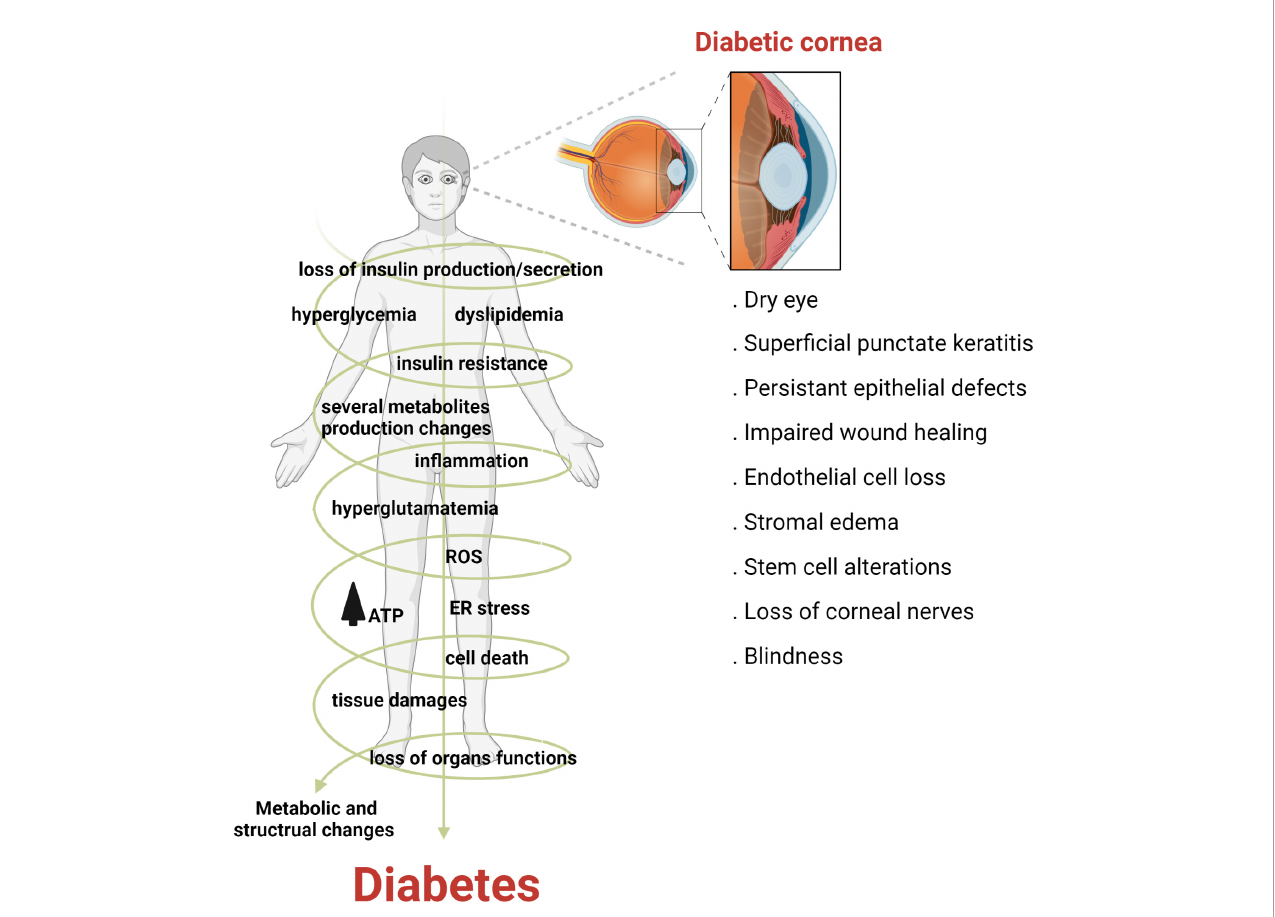
FIGURE2 Diabetes adversely effects the cornea. Diabetes is a multifactorial disease characterized by metabolic dysfunction throughout the human body. In the cornea, diabetes can cause a host of complications ranging from dry eye disease to blindness, in severe cases.